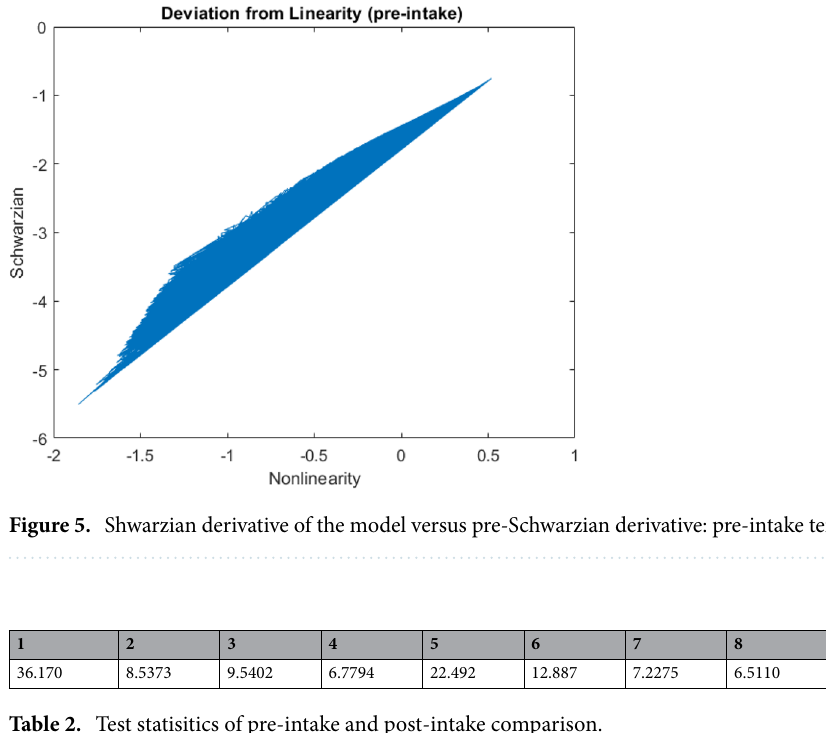
Table 2. Test statisitics of pre-intake and post-intake comparison.